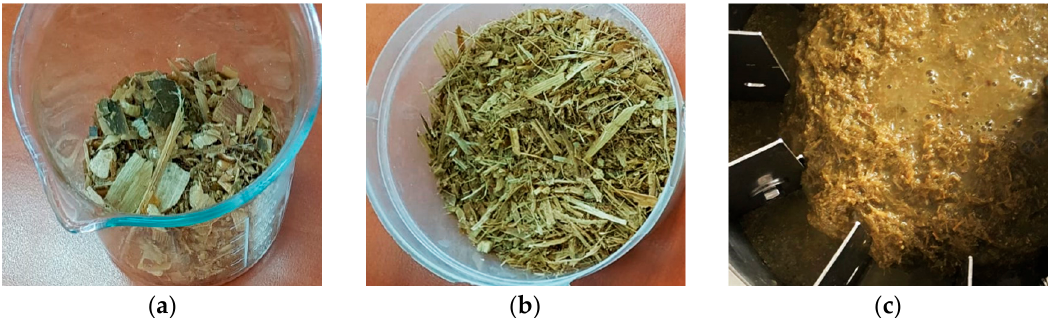
Figure 4. Maize silage: ( a ) Raw maize silage; ( b ) shredded maize silage; and ( c ) hydrated maize silage used in the hydrodynamic disintegration process.